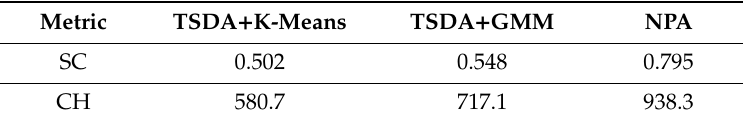
Table 4. Silhouette coefficient (SC) and Calinski-Harabaz Index (CH) with TSDA + K-Means, TSDA + GMM, and the